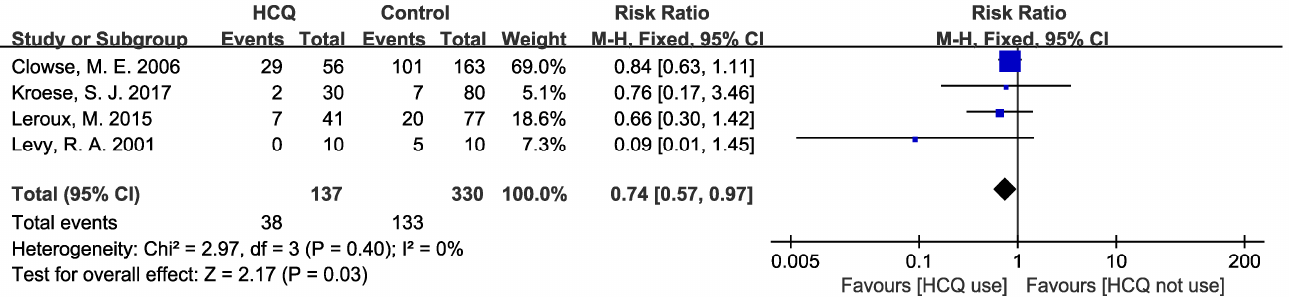
Figure 2. Forest plot for RR of high lupus activity. The pooled estimate of RR of high lupus activity was determined for patients taking HCQ compared to placebo or those not taking HCQ. Table 2. Sensitivity analyses for the risk of high lupus activity.